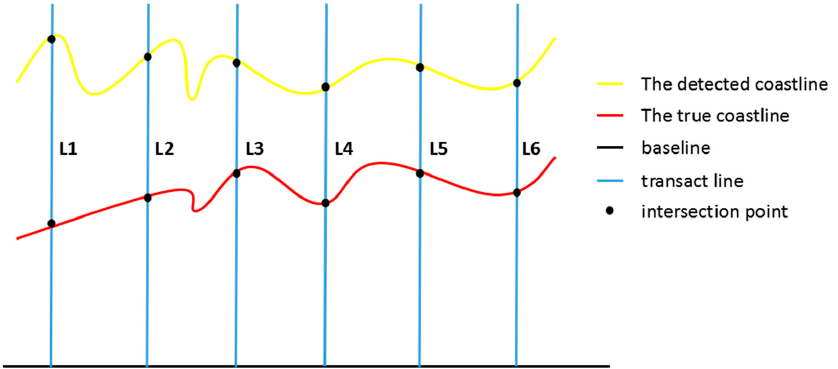
Figure 4. Principle of accuracy evaluation.